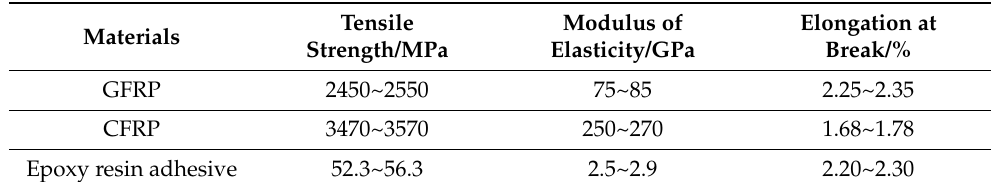
Table 2. Strength of FRP and epoxy resin adhesive.